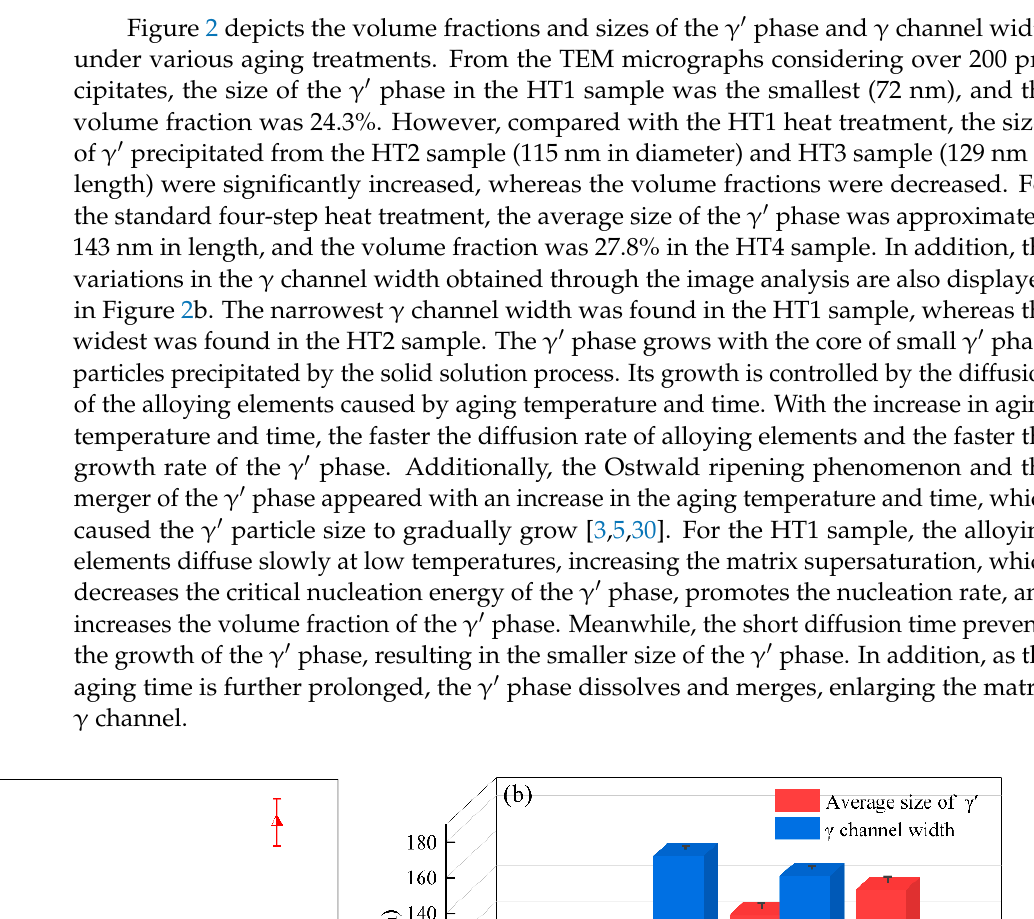
Figure 3. The variation trends in ultrasonic longitudinal velocity and volume fraction of the γ′ phase under various aging treatment conditions. The ultrasonic longitudinal velocity of the alloy was related to both Young’s modulus and density, which is in accordance with the V ∝ (E/ ρ ) 0.5 equation [14,32]. Therefore, Young’s modulus and density were the major reasons for the variation in the ultrasonic longitudinal velocity of the alloy. The γ′ precipitates throughout the heat treatment pro- cess altered the elastic modulus but showed little impact on the density of the alloy. Ac- cording to a previous study [15,32], the Young’s modulus of the γ′ phase (210 GPa) was approximately 11% higher than the γ matrix (190 GPa). As a result, the Young’s modulus of the superalloy increased with the volume faction of the γ′ phase in the microstructure, which increased the ultrasonic longitudinal velocity of the superalloy. As shown in Figure 3, for the HT4 sample with a 27.8% volume fraction of the γ′ phase, the ultrasonic longi- tudinal velocity reached the maximum value.